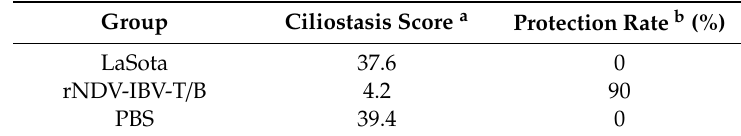
Table 3. Result of ciliostasis test scores and survival of vaccinated chickens challenged with IBV, 3 weeks post-vaccination.